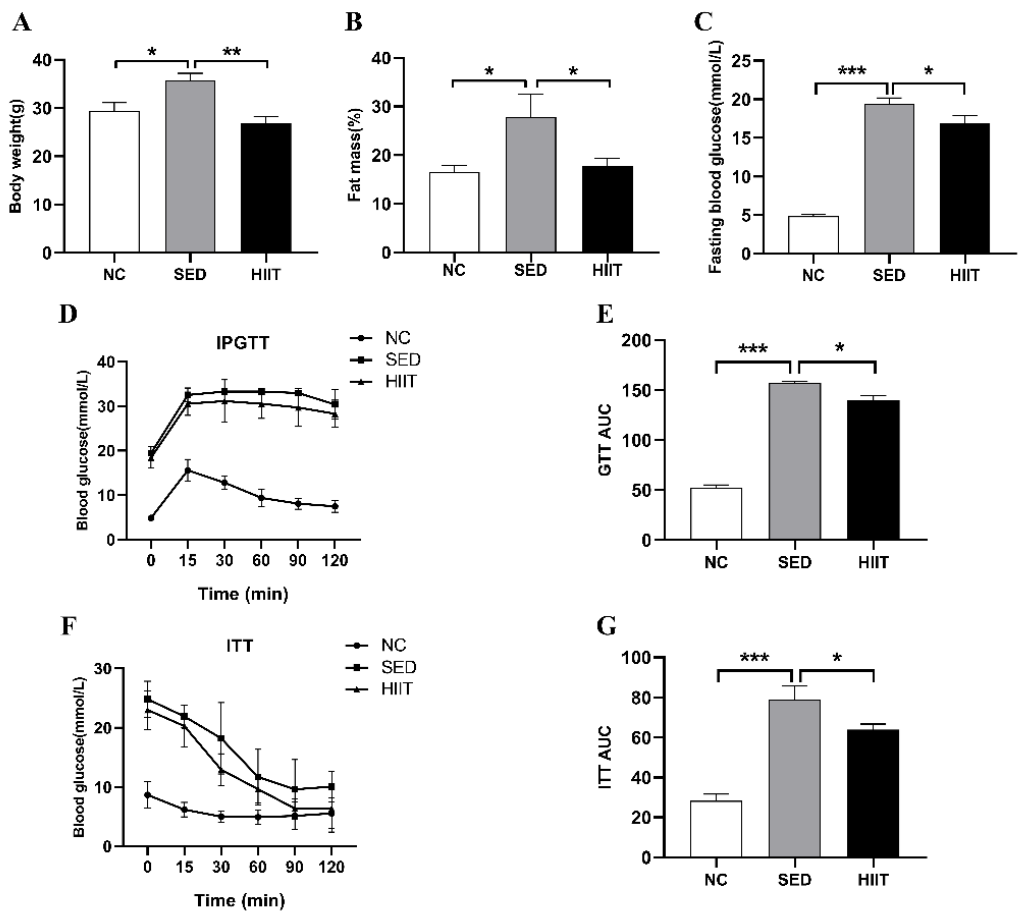
3.1. HIIT Improves Body Weight, Fat Mass, and Blood Glucose Control in T2DM Mice Compared with the NC group, the body weight ( p < 0.05) (Figure 1A), fat mass ( p < 0.05) (Figure 1B), FBG, and the AUCs of GTT and ITT ( p < 0.001) (Figure 1C–G) were significantly increased in the SED group, indicating that the T2DM mouse model was successfully established. After 8 weeks of HIIT intervention, compared with the SED group, the body weight ( p < 0.01) (Figure 1A), fat mass ( p < 0.05) (Figure 1B), FBG, and AUCs of GTT and ITT ( p < 0.05) (Figure 1C–G) were significantly decreased in the HIIT group.